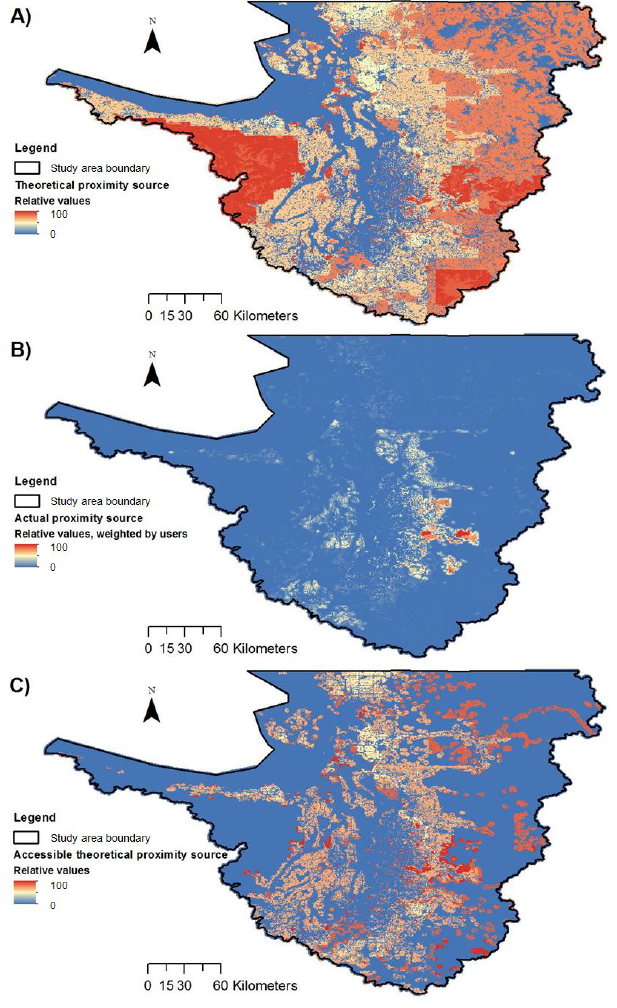
Fig. 5 . Open space proximity values in the Puget Sound Basin, showing (a) theoretical values, (b) actual values weighted by the number of homeowners, and (c) theoretical values actually accessible to